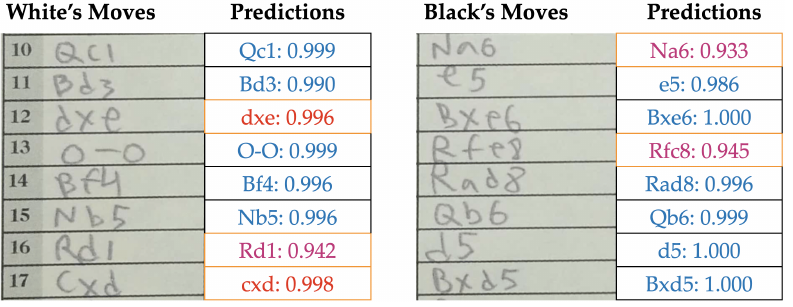
Figure 7. The network output of a scoresheet portion as presented to the user. Low confidence predictions (<95%) such as ‘Na6’ are presented in magenta, and invalid or illegal moves such as ‘dxe’ are presented in red for quick lookup and